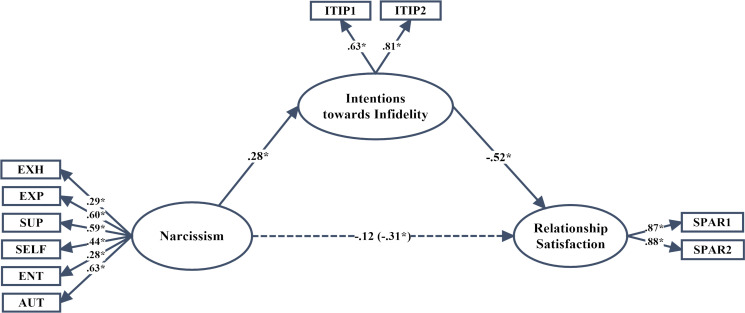
*p < .05, standardized parameter estimates of the final structural model; the parameter value given in parentheses was calculated when the effect of the other means on relationship satisfaction was released; EXH: Exhibitionism; EXP: Exploitation; SUP: Superiority; SELF: Self-sufficiency; ENT: Entitlement; AUT: Authority; ITIP1–2 = two parcels from the intentions towards Infidelity Scale; SPAR1–2 = two parcels from the Relationship Satisfaction Scale.